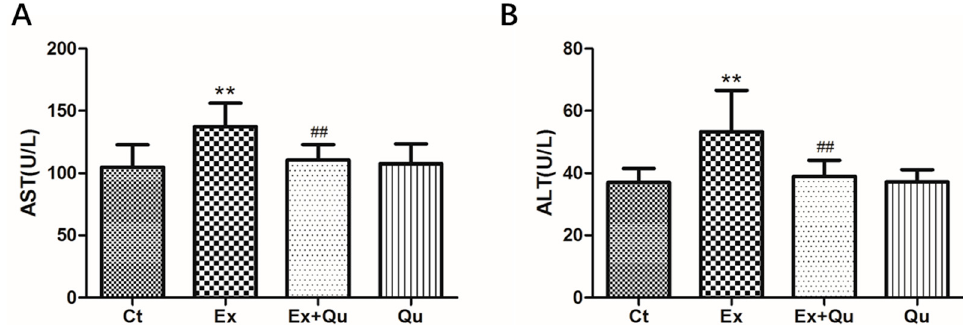
Figure 1. Effect of intensive running with or without quercetin administration on serum aspartate transaminase (AST) ( A ) and alanine transaminase (ALT) levels ( B ). BALB/c mice were pretreated or not with quercetin for 4 weeks and subsequently exposed to intensive exercise for successive 7